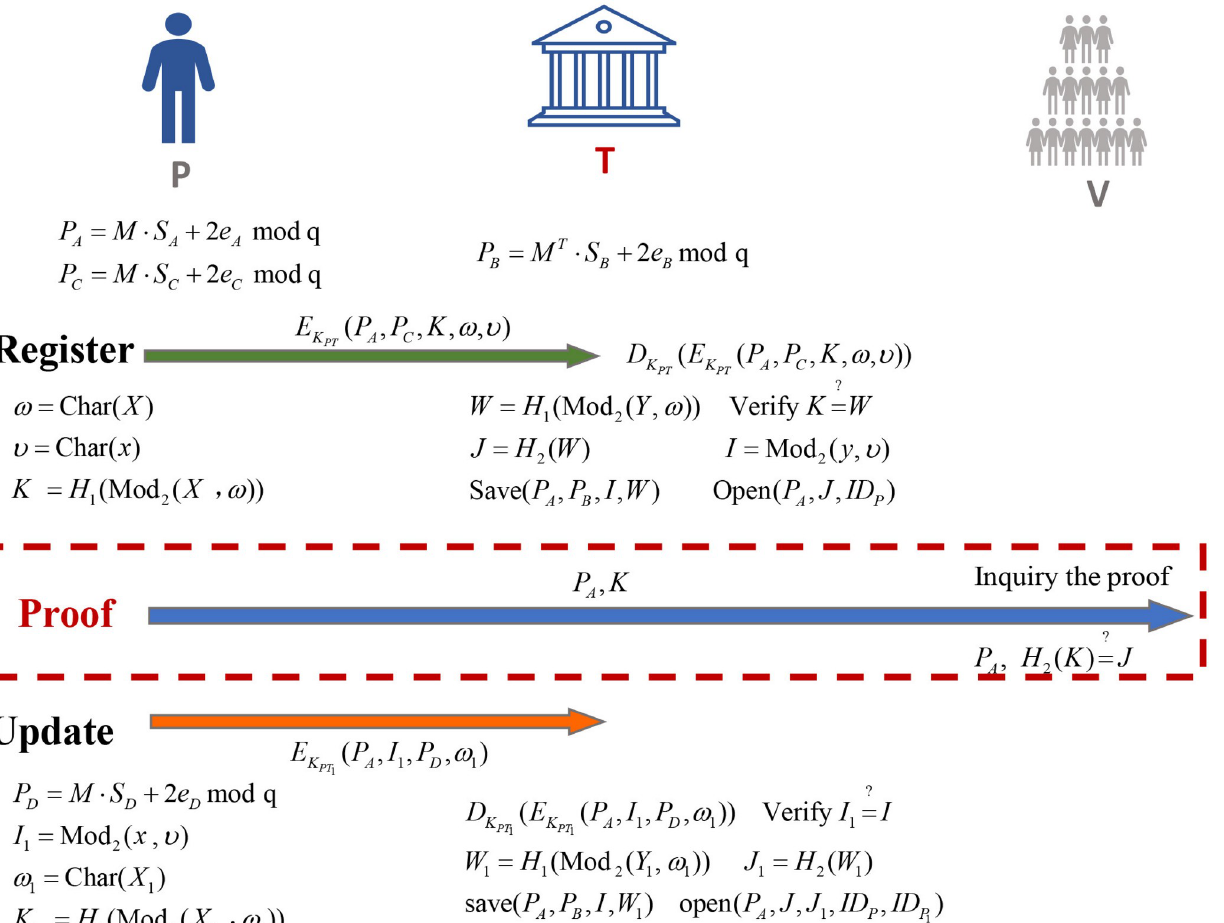
Fig 4. Publicly-verifiable non-interactive zero-knowledge based on key